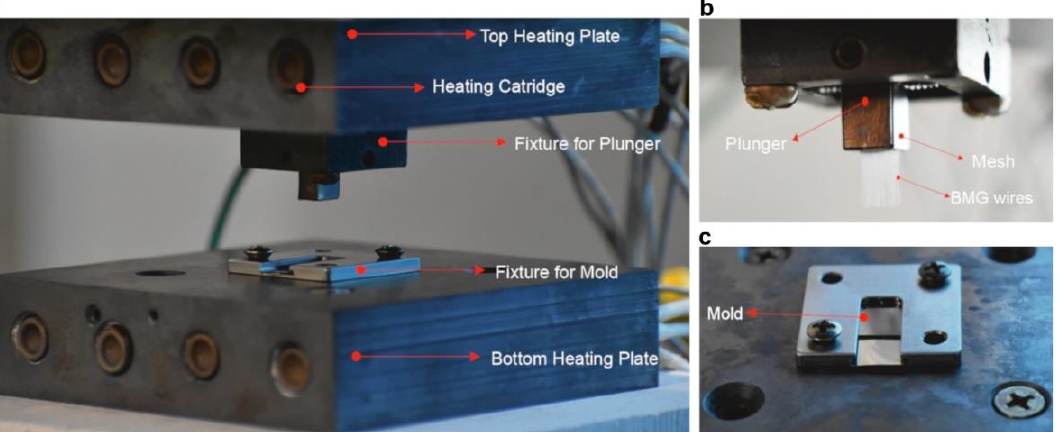
Figure 2. Experimental setup used for BMG thermoplastic drawing. ( a ) Top and bottom plates heated through resistive cartridges. ( b ) Closer view of top plunger wrapped in metal mesh showing an array of drawn BMG wires. ( c ) The metal fixture used to secure the mold on the bottom heating plate.